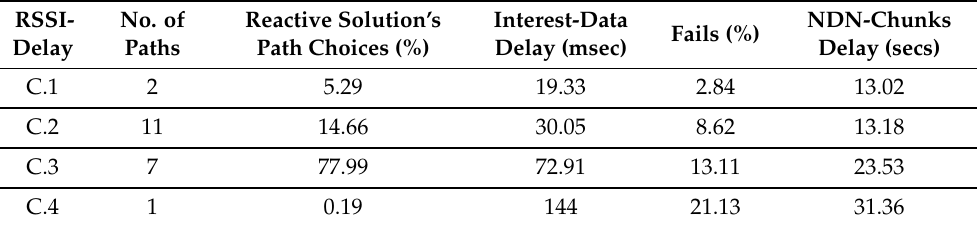
Table 10. RSSI-Delay clusters average